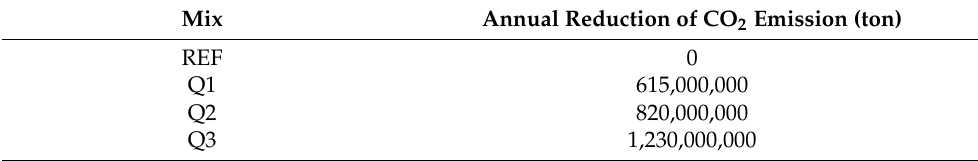
Table 9. Annual reduction of CO 2 emission in green quaternary concrete with